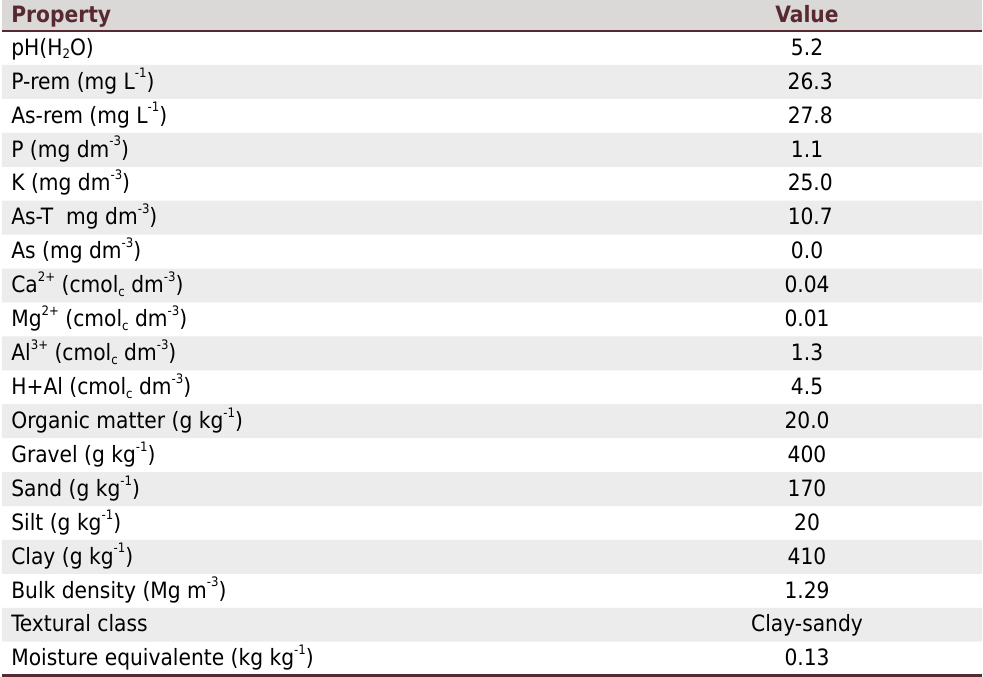
Table 1. Chemical and physical properties of the soil samples used in the experiment